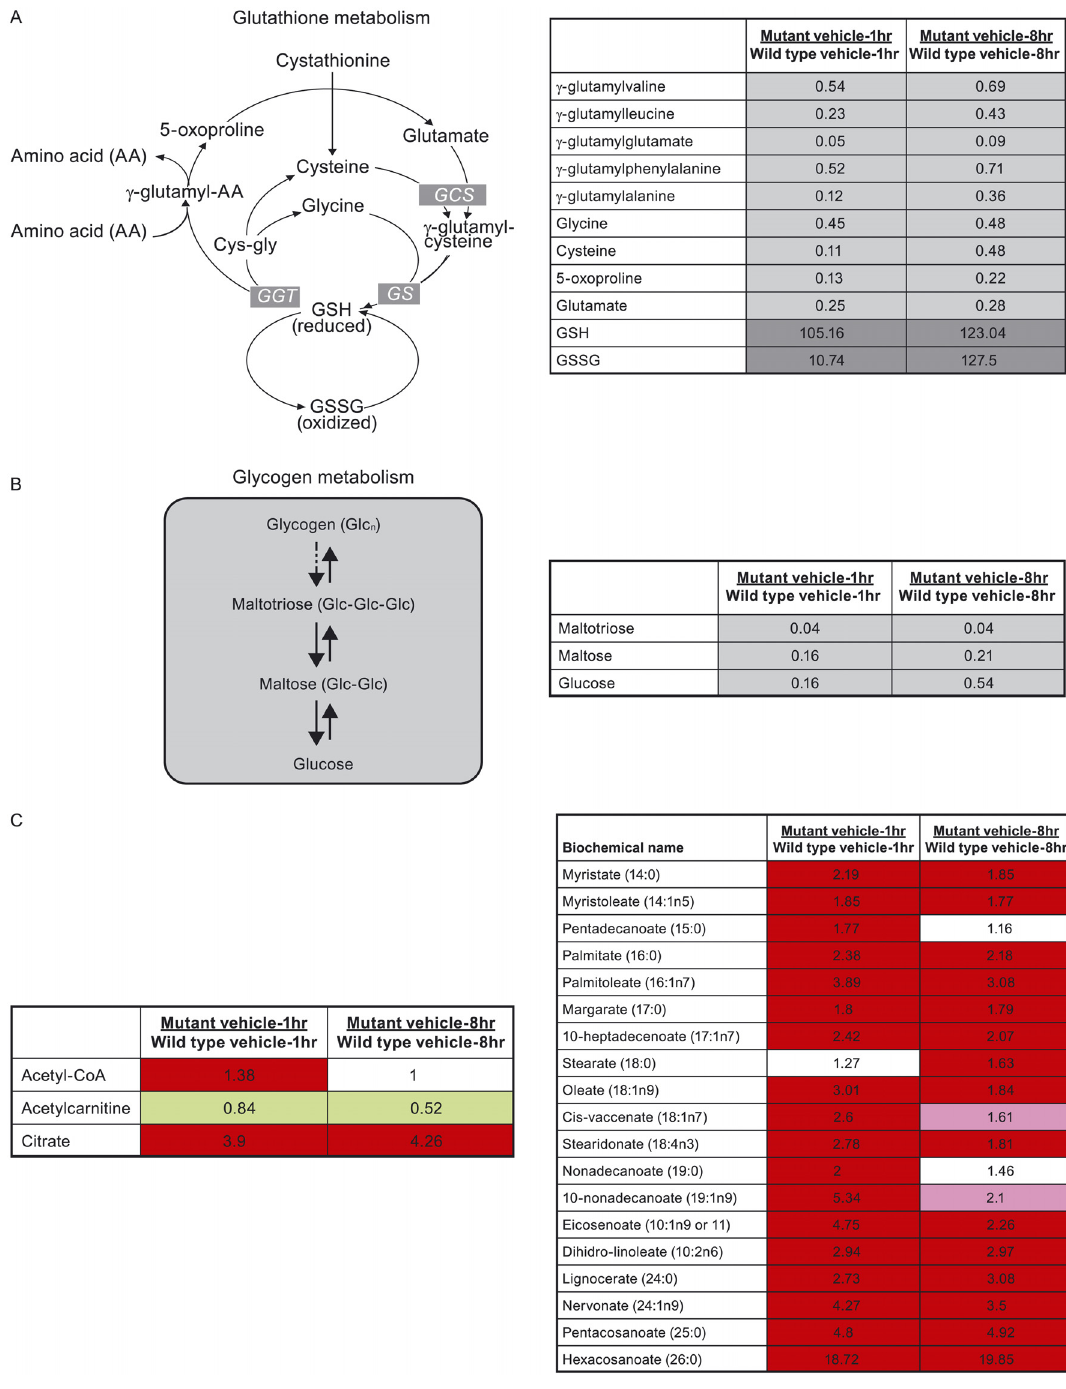
Fig 4. Baseline metabolic differences between SW48 KRAS WT and G13D mutant tumors. A-C: Glutathione metabolism pathways (A), glycogen metabolism (B) and relative expression of pathway metabolites in KRAS WT vs KRAS mutant tumors treated with vehicle for 1 and 8 hrs. The numbers indicate the fold change of each metabolite in KRAS mutant tumors compared to KRAS WT tumors and are the average of metabolite levels from 5 different tumors. C: Relative expression of free long chain fatty acids, acetyl coA, acetylcarnitine and citrate in KRAS mutant vs KRAS WT tumors. Green boxes indicates a ratio < 1, with dark green boxes as highly significant (p (cid:1) 0.05) and light green boxes as less significant (0.05 < p < 0.1). Red boxes indicate a ratio > 1, with dark red boxes as highly significant (p (cid:1) 0.05) and light red boxes as less significant (0.05 < p < 0.1). White boxes represent no change in expression.